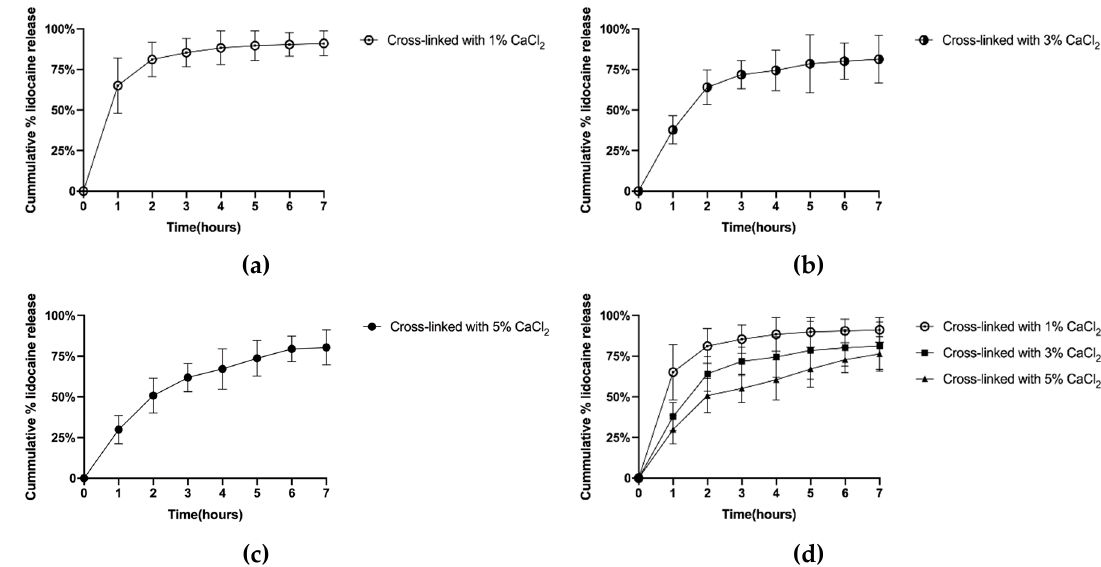
Figure 7. Evaluation of the lidocaine release behavior of 9% ( w/v ) alginate/CMC/PEO nanofiber films by crosslinking degree. All data were obtained from HPLC. ( a ) is the release behavior of the crosslinked alginate/CMC/PEO nanofiber film with 1% ( w/v ) CaCl 2 . ( b ) and ( c ) show the release behavior of the crosslinked alginate/CMC/PEO nanofiber films with 3% and 5% ( w/v ) CaCl 2 . ( d ) is a comparative analysis of the HPLC data in ( a ), ( b ), and ( c ).